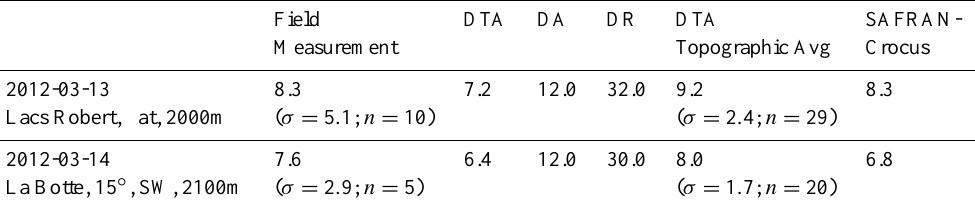
Table 5. Measured, MODIS retrieved and SAFRAN-Crocus simulations of SSA (m 2 kg − 1 ) on two different locations of the Belledonne massif during winter 2012. For field measurements, σ and n are the standard deviation and number of measurements carried out in each pixel. DTA, DA and DR refer to the MODIS-derived SSA at the location of measurements. MODIS DTA Topographic Avg is the mean SSA within the retrieved pixels of the Belledonne massif belonging to the same topographic class (massif, elevation, slope, aspect). In this case, σ is the standard deviation within these pixels and n their